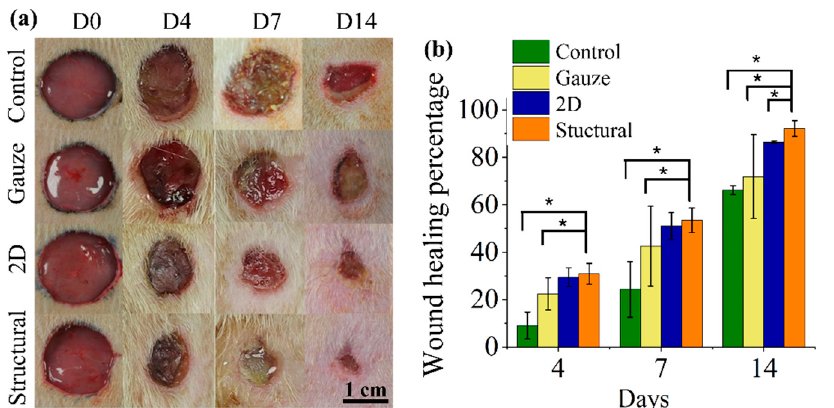
Figure 9. ( a ) Representative images of wounds from different groups: control (no treatment), treated with commercial gauze, treated with 2D nanofibers in random orientation and treated with structural nanofibers at days 0, 4, 7 and 14. ( b ) Analysis of wound healing rate. The symbols * represent p < 0.05, for comparison between the structural scaffolds to other groups.